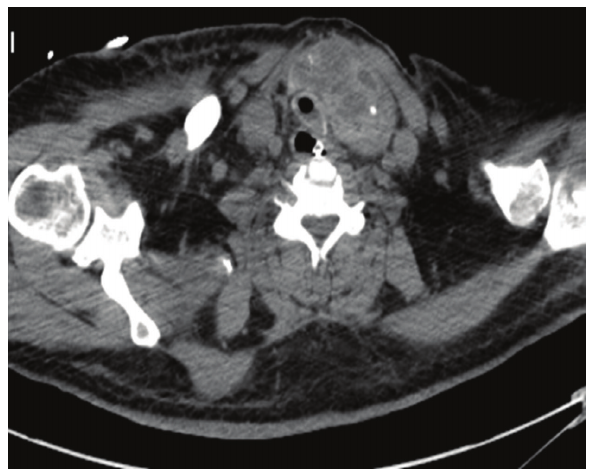
Figure 1: A CT in a patient with a short neck and with a very large goiter. The CT cut is approximately 1 cm above the sternal notch. The trachea is surrounded by the goiter and cannot be safely reached from the anterior portion of the neck, unless thyroidectomy is performed in advance.